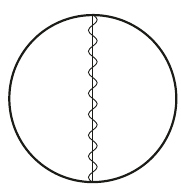
Figure 7 . The graphical representation of the g 2 -correction to